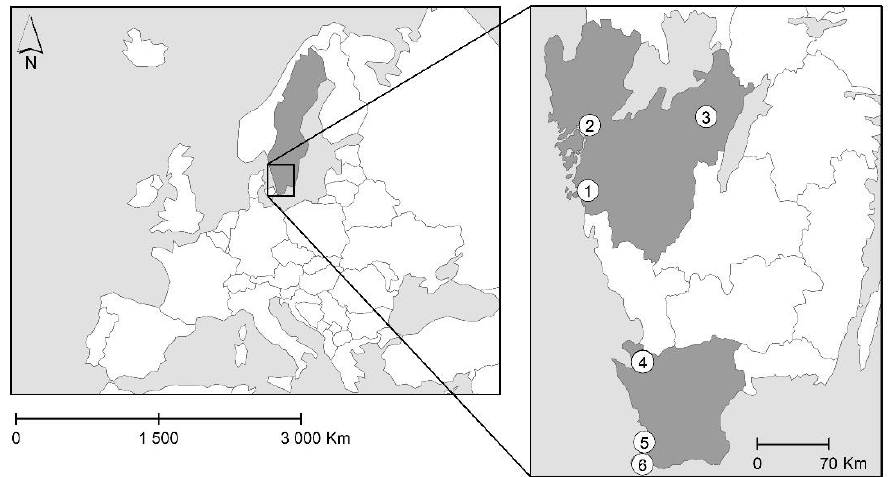
Figure 3. Map of studied municipalities (numbers) and counties (grey areas) in Sweden. ① Göteborg, ② Uddevalla, ③ Skövde, in the County of Västra Götaland, and ④ Ä ngelholm, ⑤ Malmö, ⑥ Vellinge, in the County of Skåne. Source: Made with Natural Earth; Statistics Sweden.